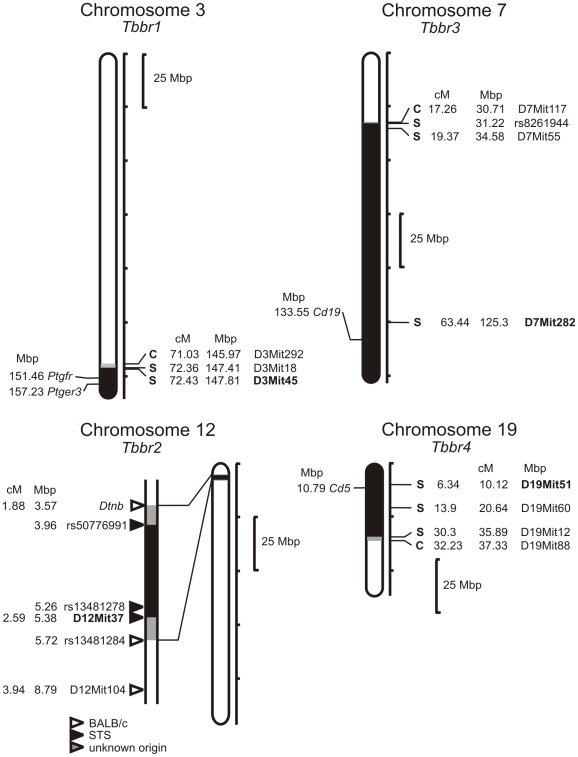
Position of the loci that control response to T. b. brucei in strain CcS-11.The regions of STS and BALB/c origin are represented as dark and white, respectively; the boundary regions of undetermined origin are shaded. Only the markers defining the boundaries the STS-derived segment and the markers that were tested for linkage are shown. The markers that exhibit significant P values (corrected for genome-wide search) are shown in bold.